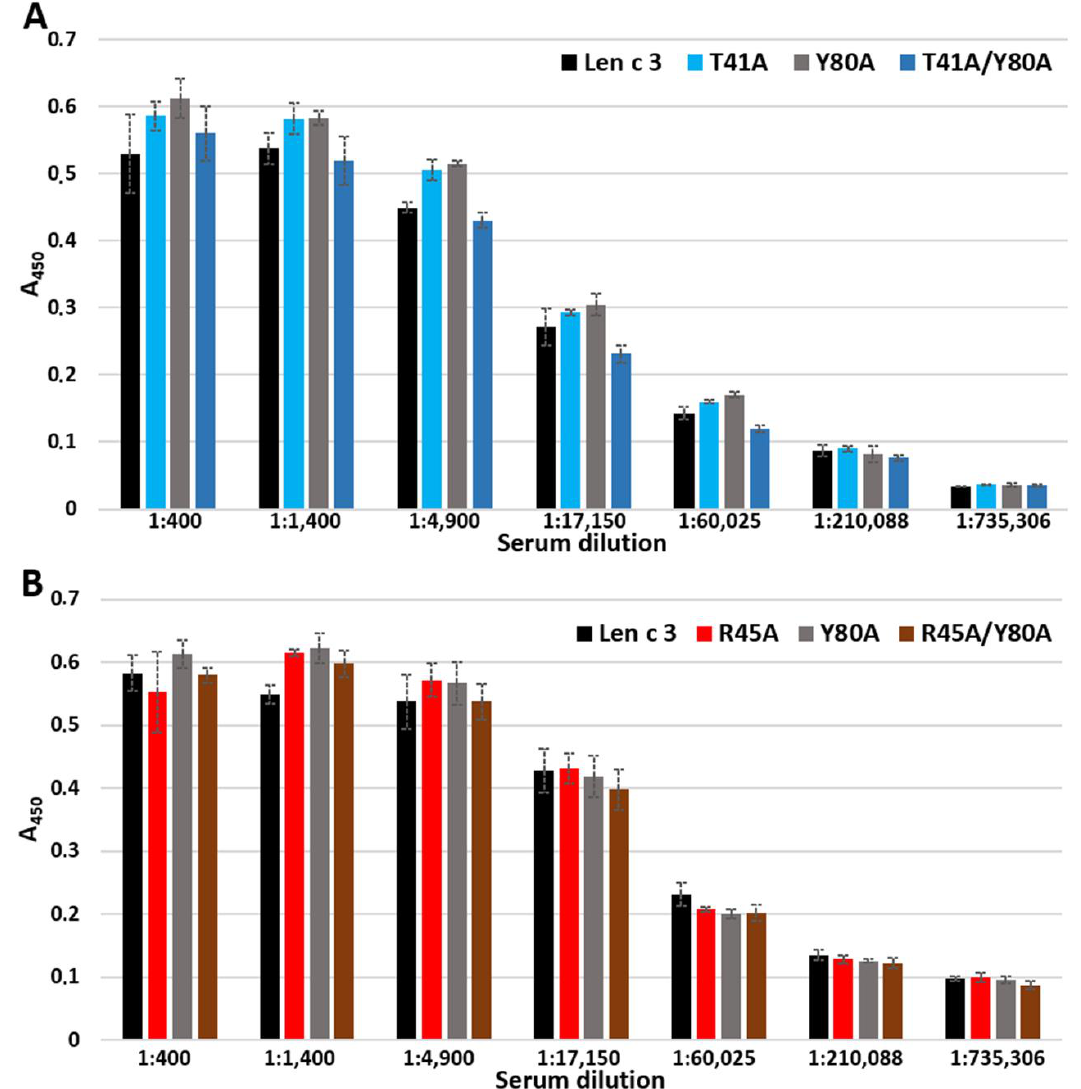
Figure 5. ELISA with Len c 3 and its mutant analogues using rabbit polyclonal anti-Len c 3 antibodies. ( A ) Comparison between Len c 3 and its mutant analogues T41A, Y80A and T41A/Y80A. ( B ) Comparison between Len c 3 and its mutant analogues R45A, Y80A and R45A/Y80A. Error bars represent standard deviation between technical replications.